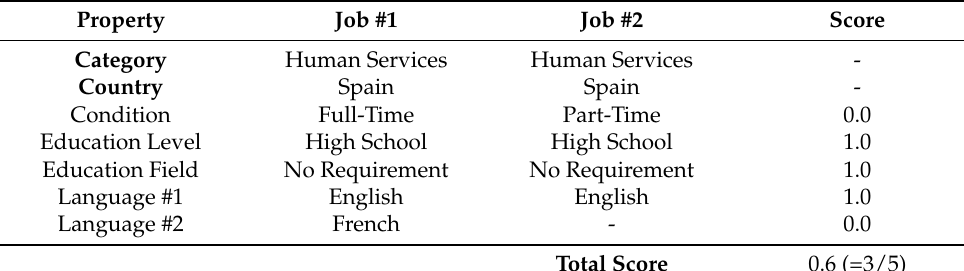
Figure 14. CQ_07: Which job posts are similar to each other? Table 9. Post similarity